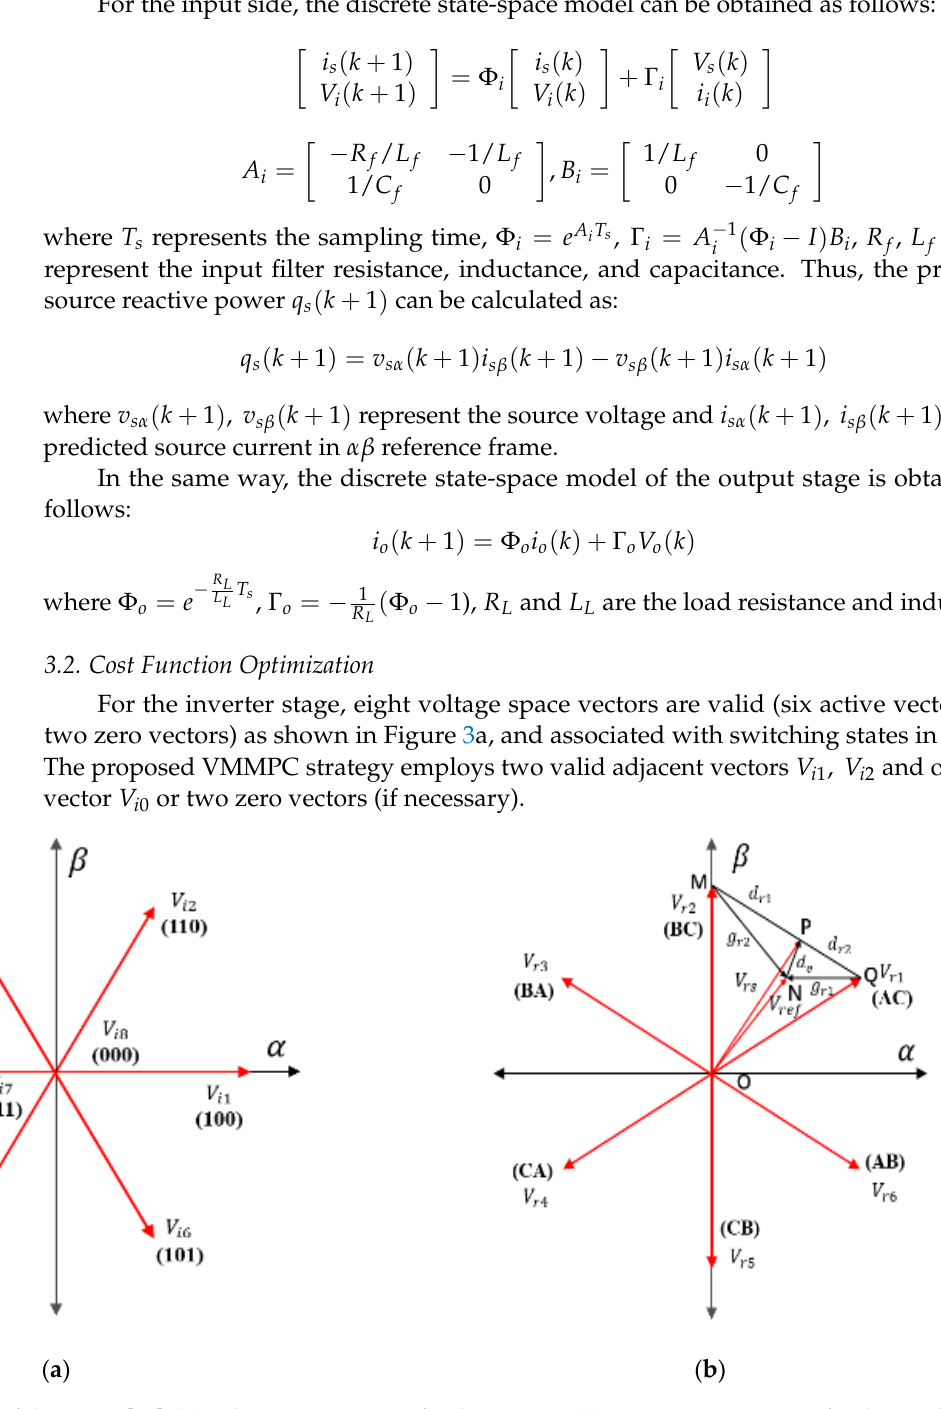
Figure 3. Space vectors of the TSMC [10]: ( a ) Voltage space vectors for the inverter. ( b ) Current space vectors for the rectifier.